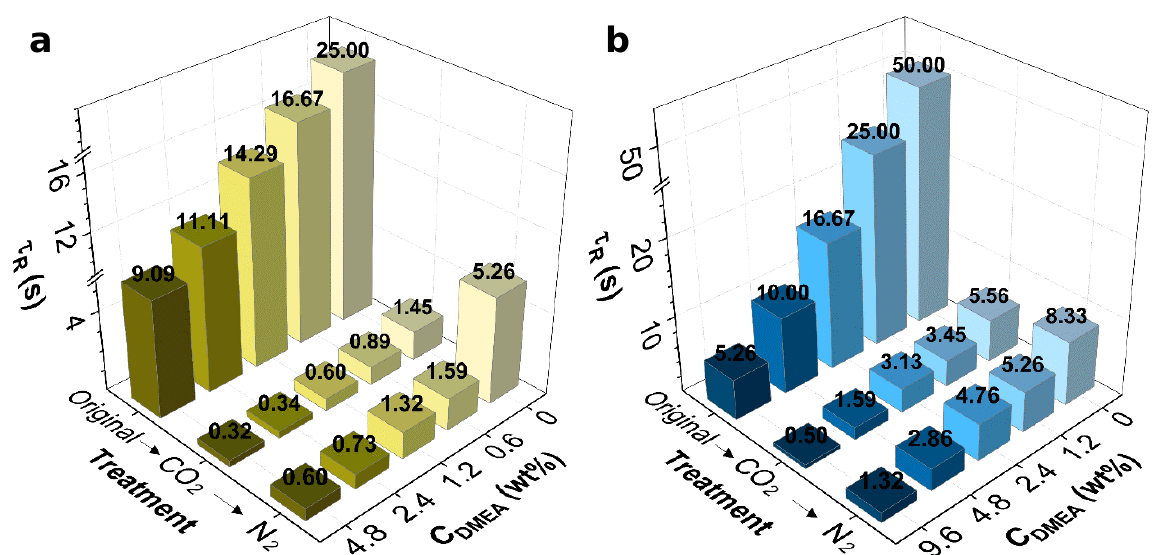
Figure 5. Variation in maximum relaxation time τ R of ( a ) 0.65 wt%, and ( b ) 1.30 wt% NaPAA solutions with different DMEA concentrations before and after bubbling CO 2 and N 2 at 25 °C.